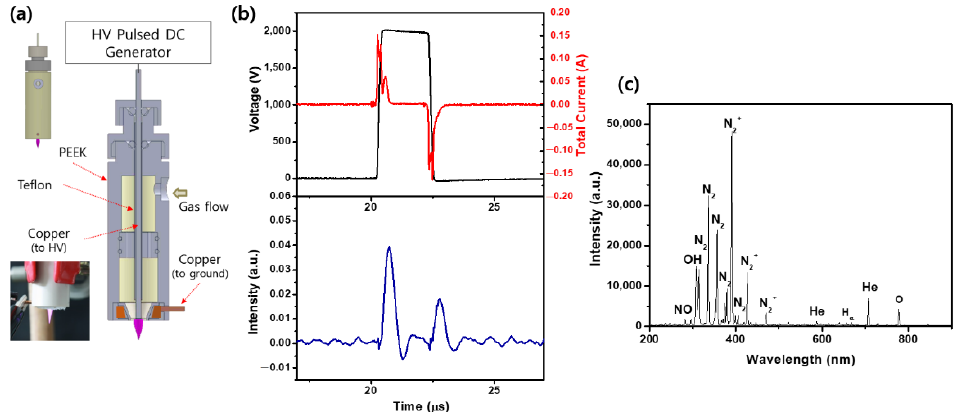
Figure 1. ( a ) Schematic of experimental setup and photograph of plasma plume. ( b ) Waveforms of the voltage (1.9 kV pp ) and total current (the upper row of the figure) and temporal evolutions of the wavelength-integrated optical emission intensities at the nozzle exit (the bottom row of the figure). ( c ) Optical emission